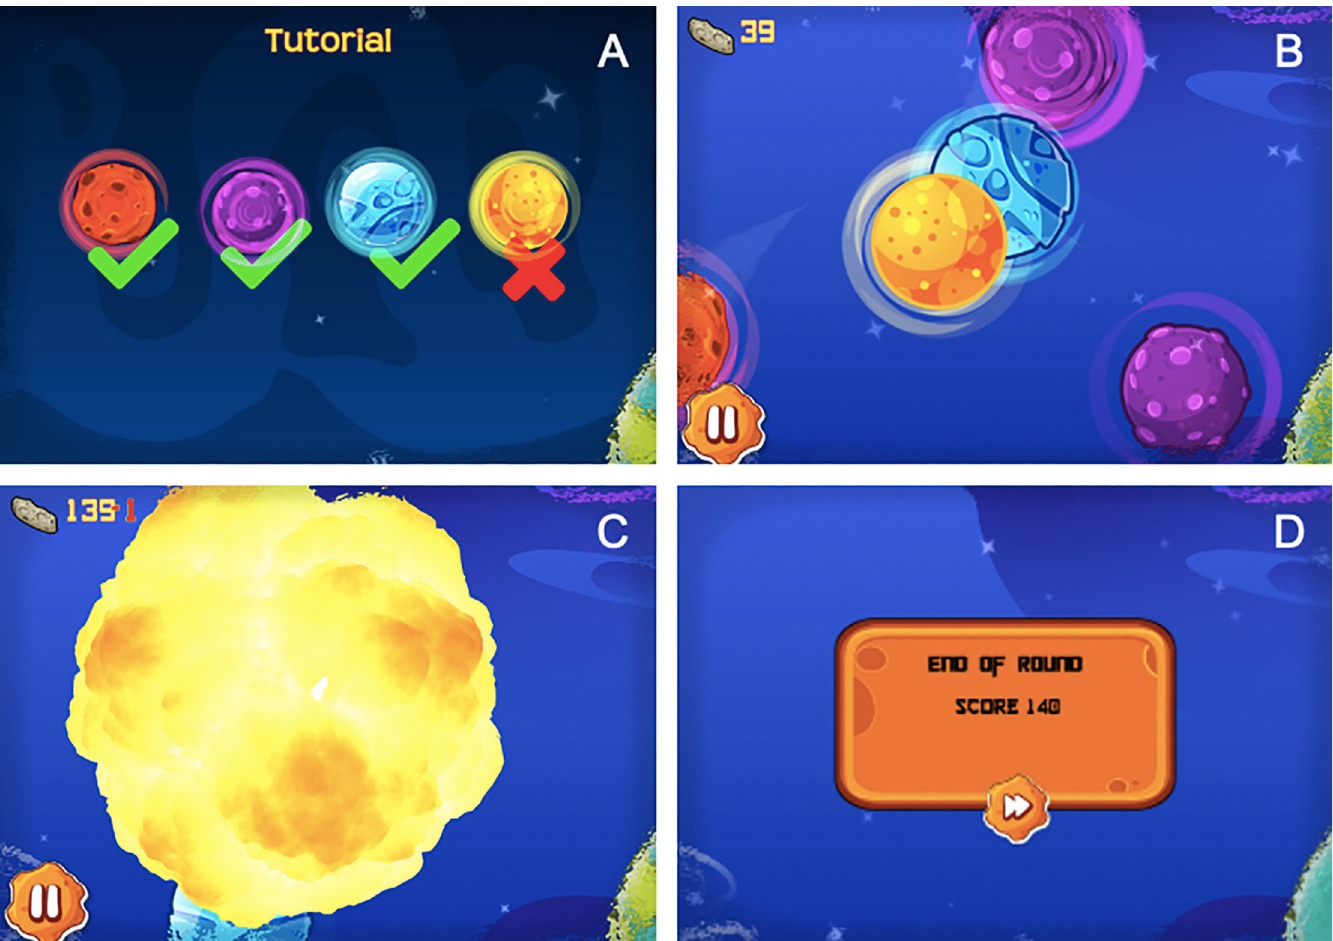
Fig 1. Screenshots depicting gameplay during CALM-IT. (A) Tutorial screen with the instructions to swipe targets (red, purple, and blue objects) and avoid swiping stars (yellow) (B) Screen capture from in-level play depicting targets and stars (C) Explosion and negative point indicator feedback in response to incorrectly swiping a star (D) Display of end of level cumulative